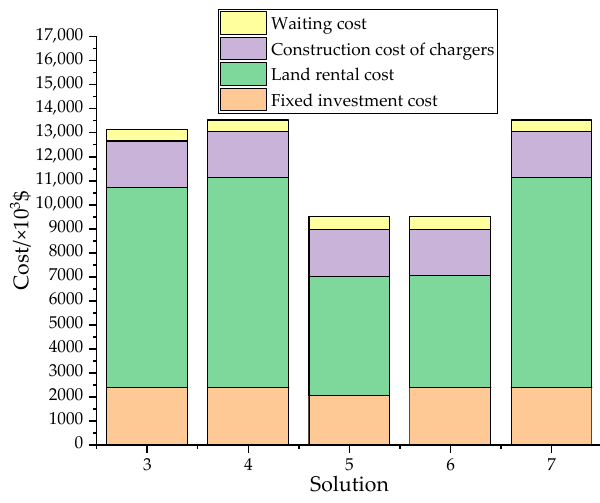
Figure 16. The detailed total social cost for each solution.